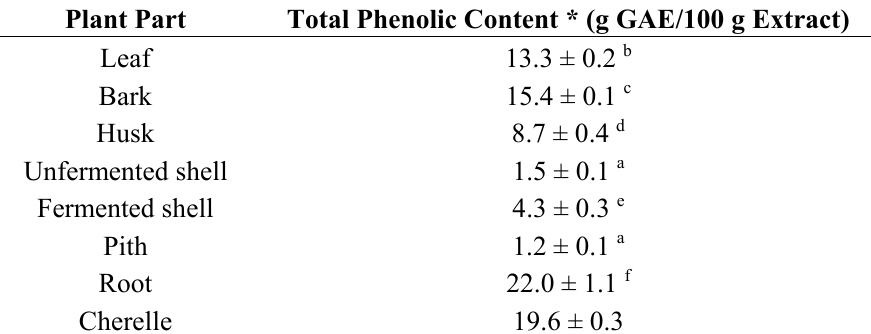
* Values are means of three replicate samples ( n = 3). Data are presented as the mean ± SEM. Superscript letters indicate significant difference according to the Tukey honest significant difference test ( p <